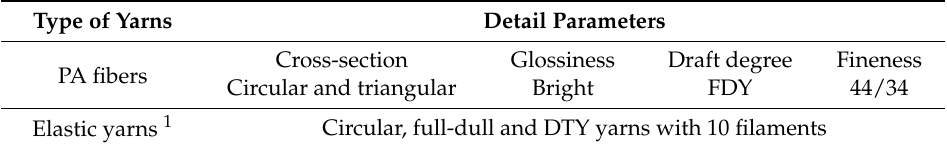
Table 1. The detail specifications of PA fibers and elastic yarns.